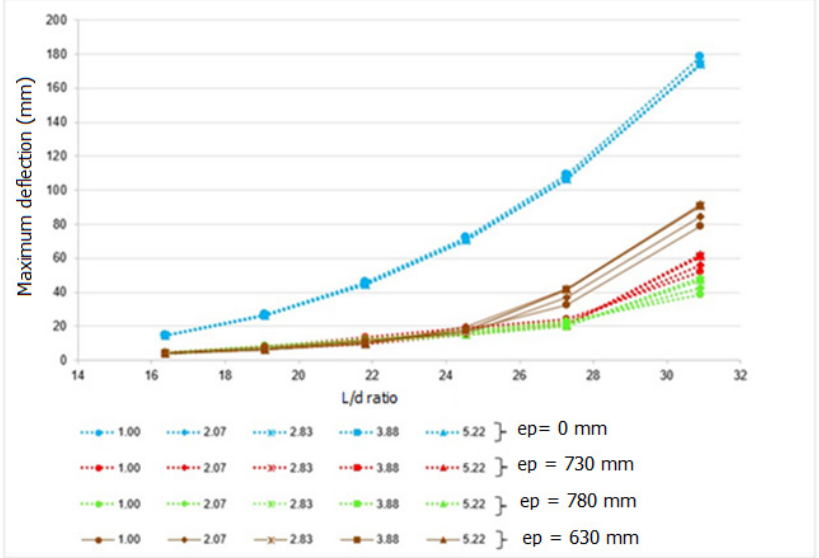
Figure 18. Maximum deflection of the beams at